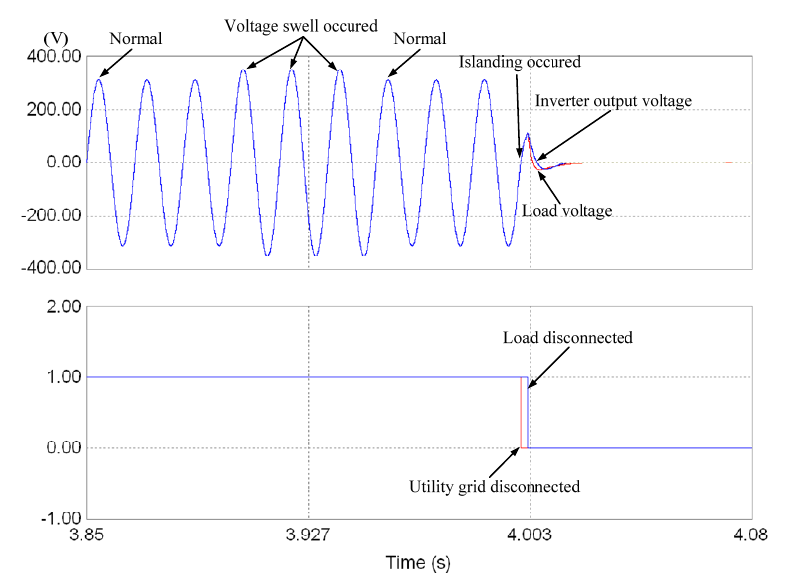
Figure 6. Diagram of simulated islanding detection during voltage swelling.